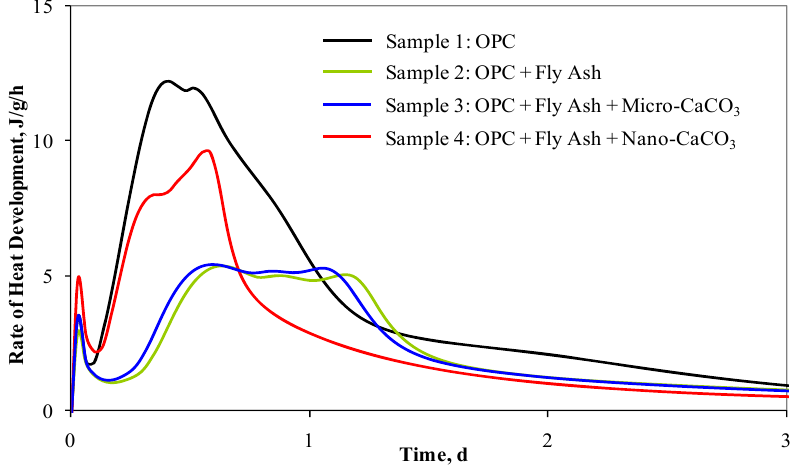
Figure 14. Microhardness measurement for the hydration of 1-day and